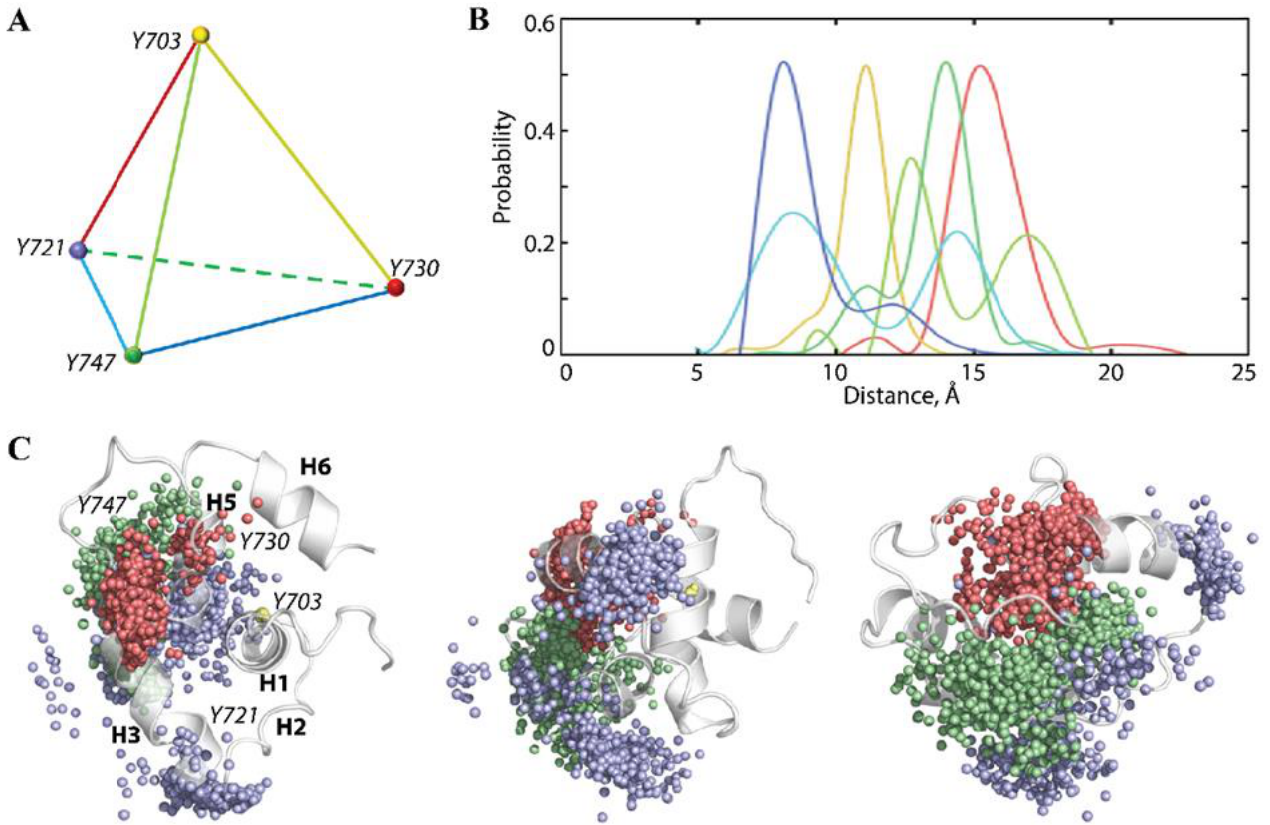
Figure 3. The cumulative spatial position of the tyrosine residues Y721, Y730, and Y747 relative to Y703 from the conserved αH1 -helix. ( A ) The tetrahedron is defined on the Cα -atoms (vertex) of each tyrosine. ( B ) Probability of distances between each pair of tyrosine residues (tetrahedron edges). Curves are coloured as tetrahedron edges ( A ). ( C ) Position of the C α -atoms of each tyrosine residue– Y703 (yellow), Y721 (lilac), Y730 (red), and Y747 (green), projected into the KID GC 3D structure (grey cartoon) after alignment on αH1 -helix (A701-N705) and shown at three orientations: top (left), side (middle), and front (right), with respect to the αH1 axe. Each point (MD frame) took 5 ns of the 14- µs MD concatenated trajectory.